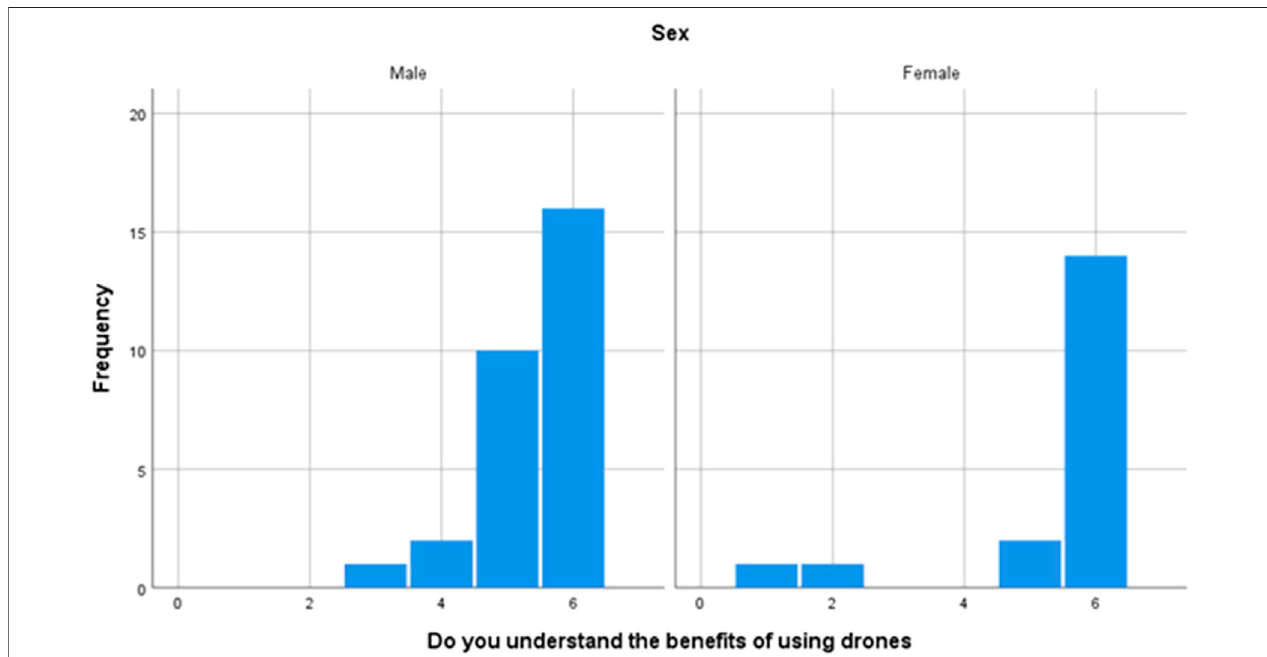
FIGURE 8 | Questionnaire participants results for the understanding of the bene fi ts of using drones on a construction site.